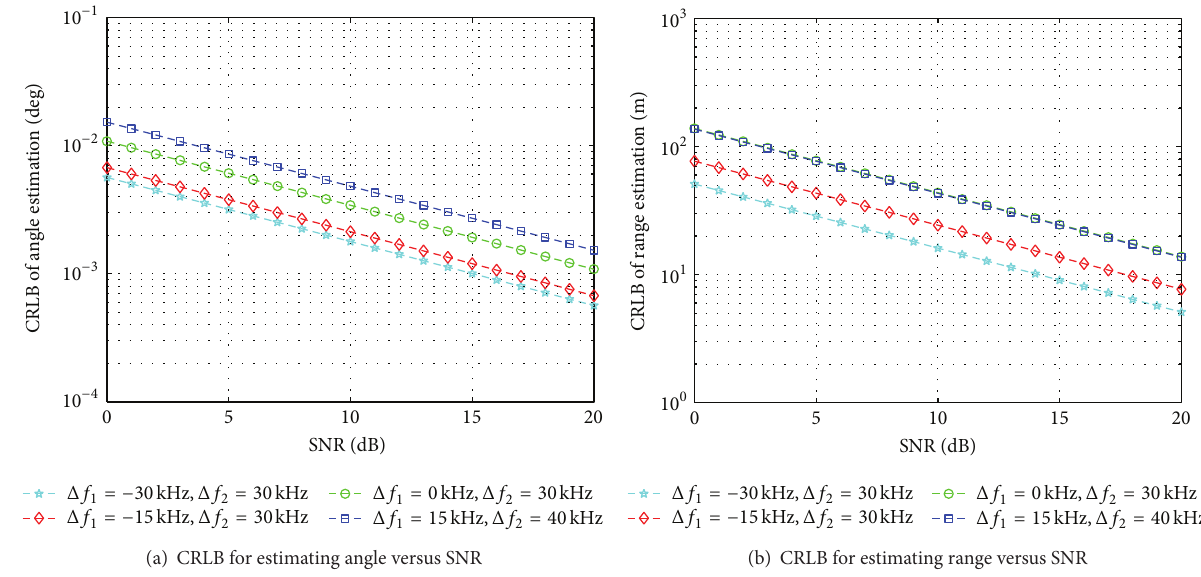
Figure 6: CRLBs of TS-FDA radar with 𝑀 = 20